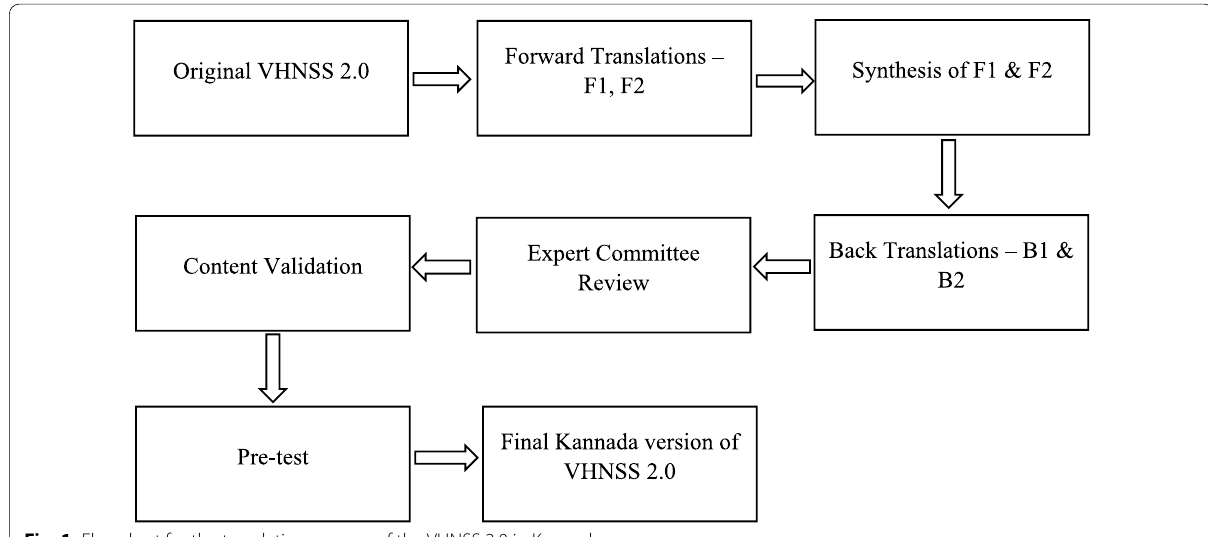
Fig. 1 Flowchart for the translation process of the VHNSS 2.0 in